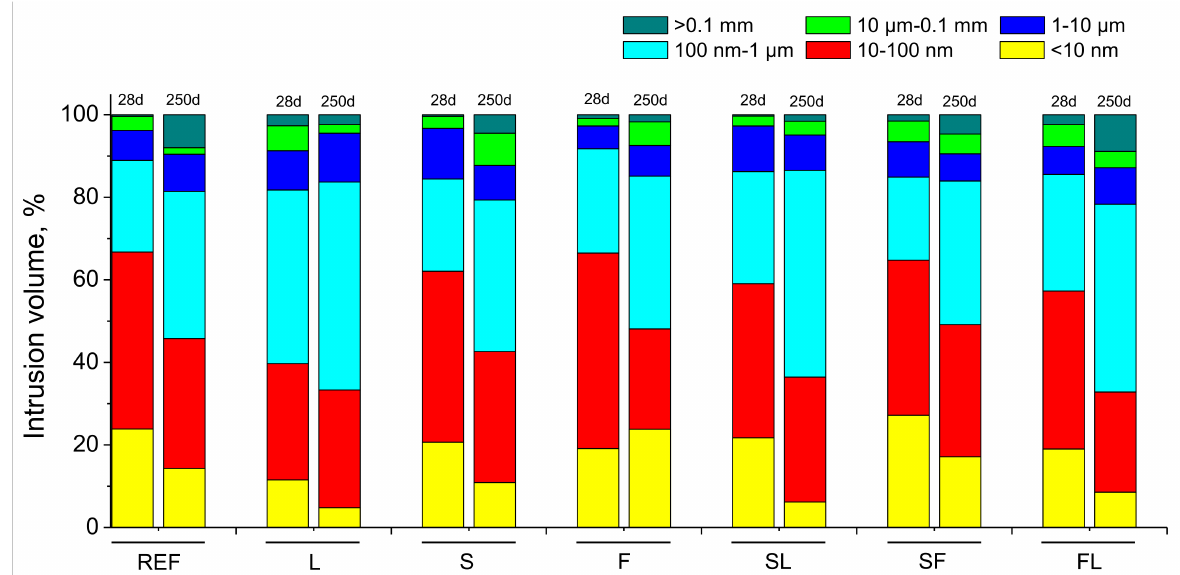
Figure 7. Pore size distributions obtained for the studied mortars.